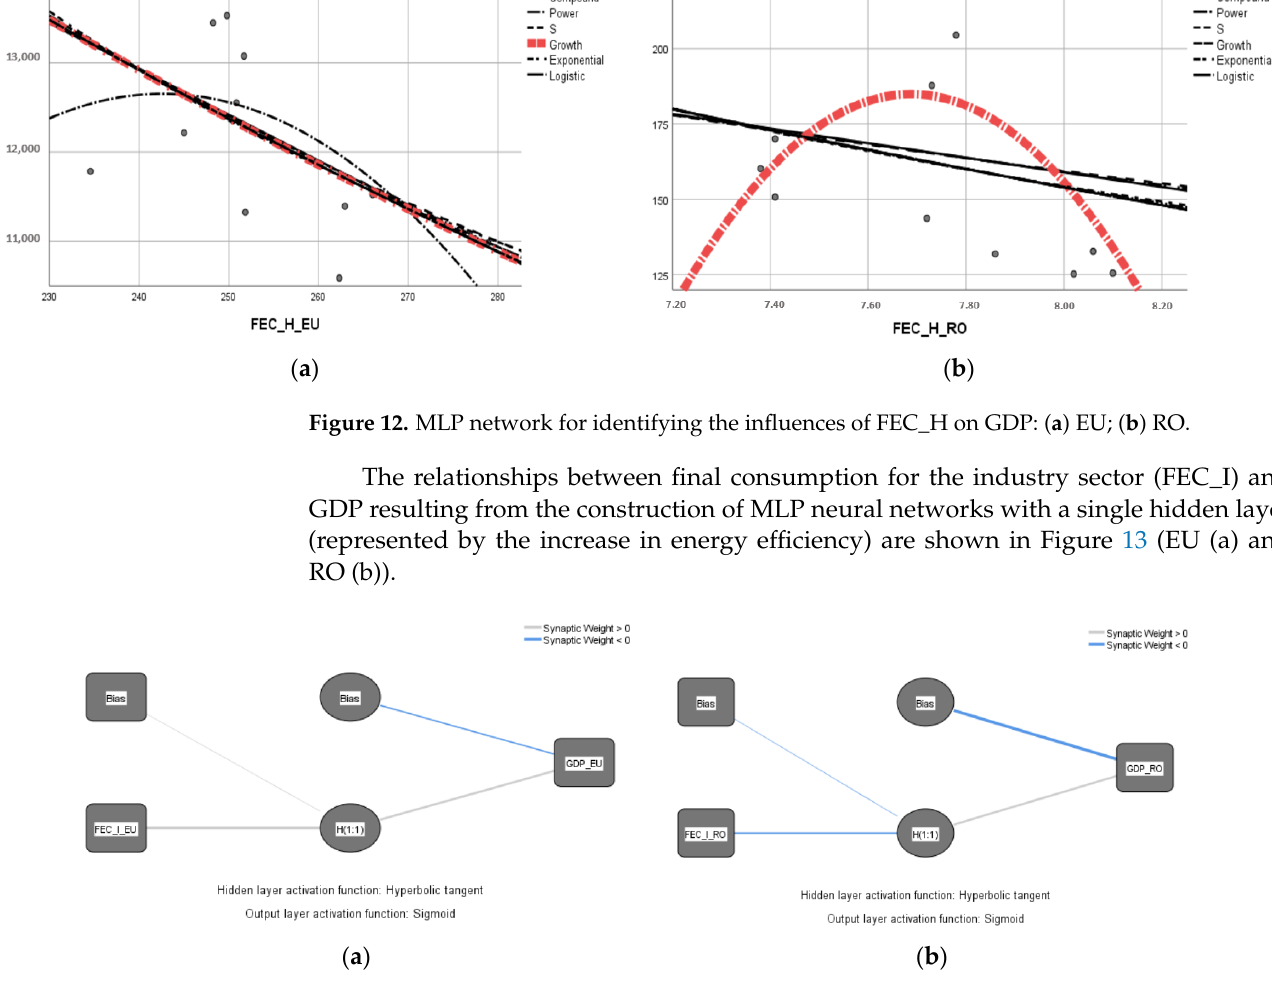
Figure 13. MLP network for identifying the influences of FEC_I on GDP at the EU and RO levels: ( a ) EU; ( b ) RO. ( a ) EU; ( b )